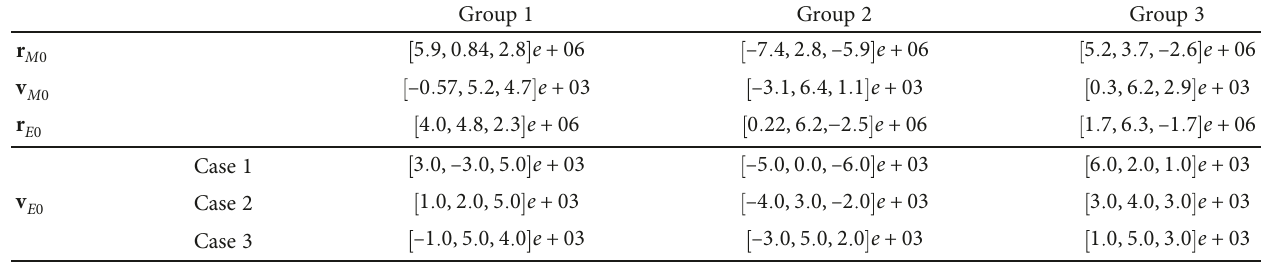
Table 1: Initial conditions for